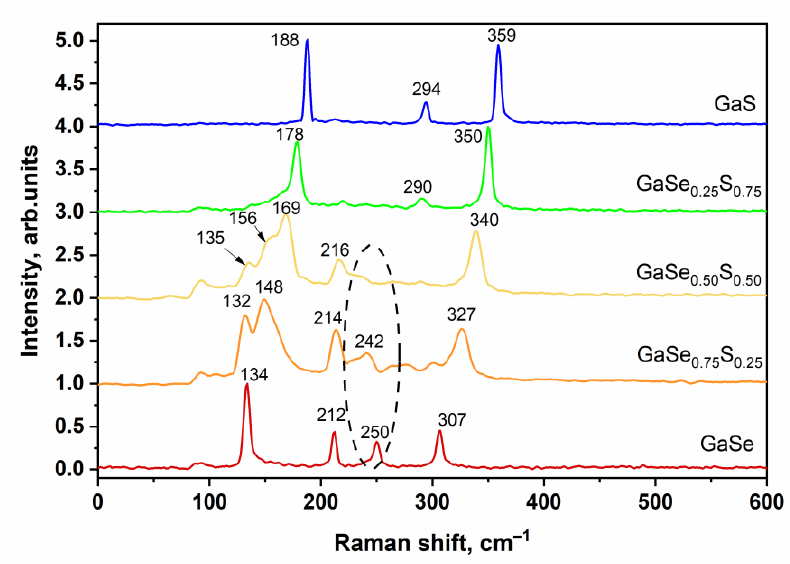
Figure 6. Raman spectra of the LPE GaSe 1 − x S x flakes.